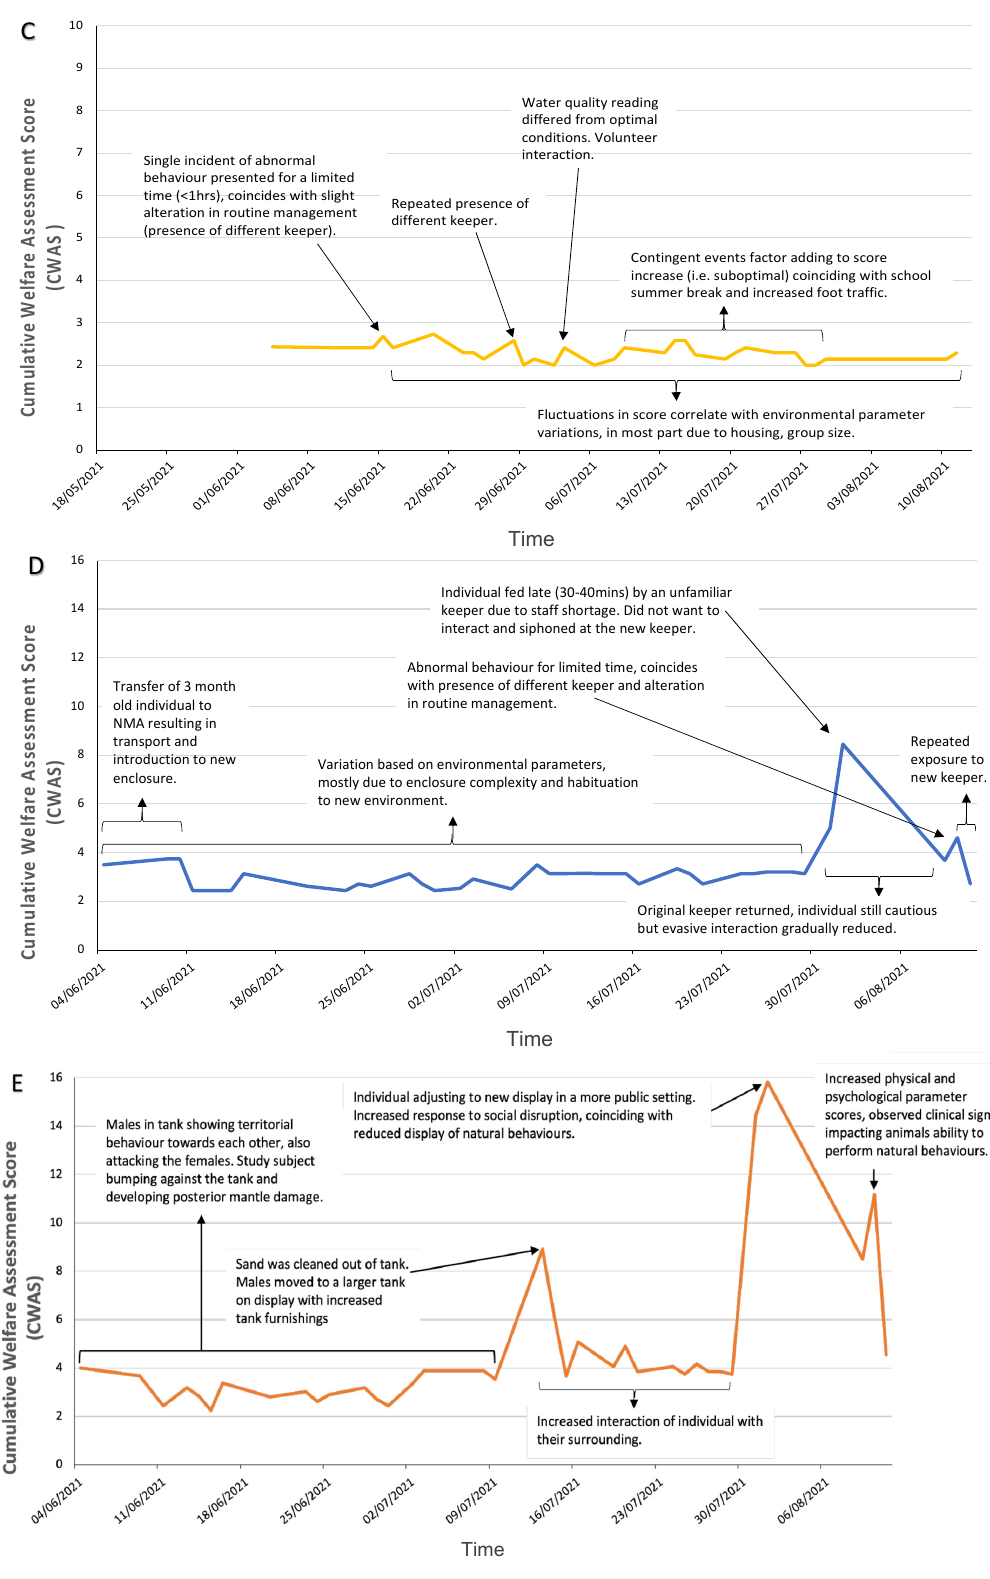
Figure 3. Daily cumulative welfare assessment scores over time for each of the three decapod species ( A ) crayfish, ( B ) shore crab, ( C ) squat lobster, and the two cephalopod species ( D ) common octopus and ( E ) cuttlefish. Annotation of the graphs indicates events that occurred around the time the peak in welfare score was noted (increased value indicates reduction in welfare). A line of general trends is displayed for the days that data were not collected.